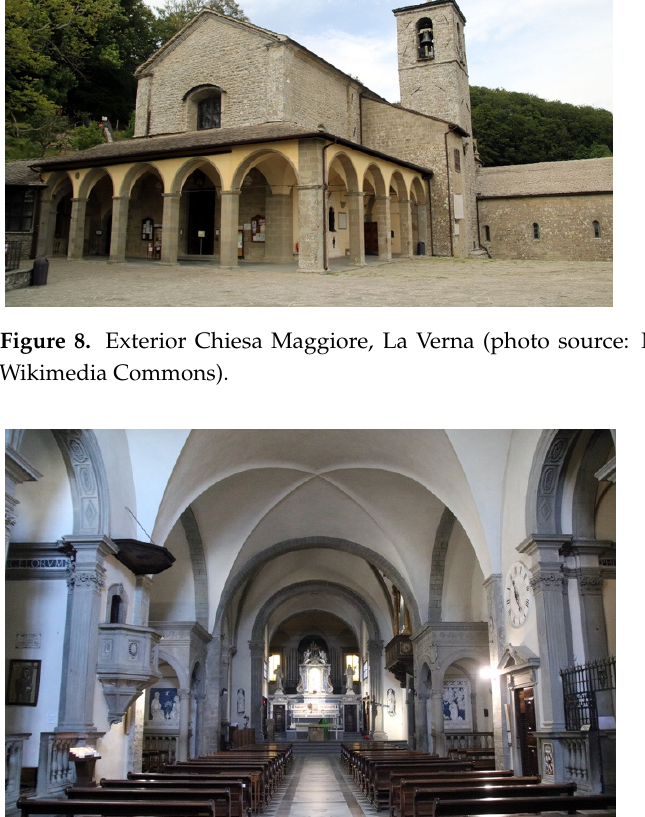
Figure 9. Interior Chiesa Maggiore, La Verna (photo source: Mongolo1984, CC BY-SA 4.0, via Wikimedia Commons).